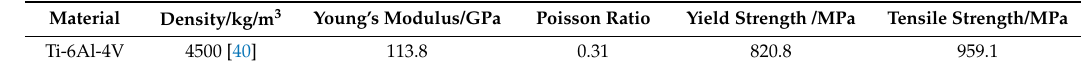
Figure 5. ( a ) The print direction; ( b ) 3D printing specimens; ( c ) tensile specimens size; ( d ) tensile test; and ( e ) true stress-strain of material. Table 3. Material